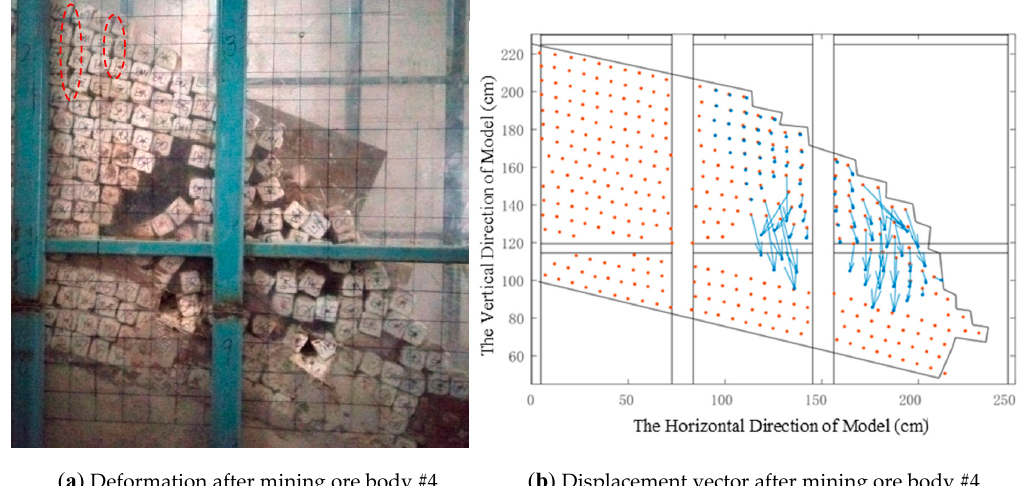
Figure 12. Slope deformation and displacement vector after mining ore body #4.